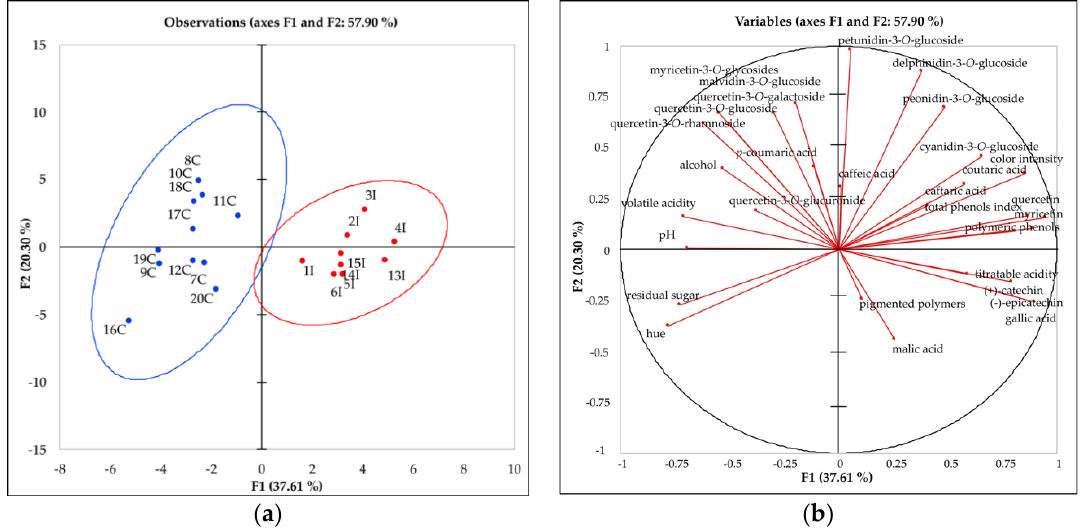
Figure 1. Principal component analysis (PCA) scores ( a ) and loadings ( b ) plots of eligibility profile (standard chemical parameters, color indices, and polyphenol compounds) for Sangiovese wines from Italy (in red) and California (in blue) from 2017 harvest. See Table 1 for the wine codes.